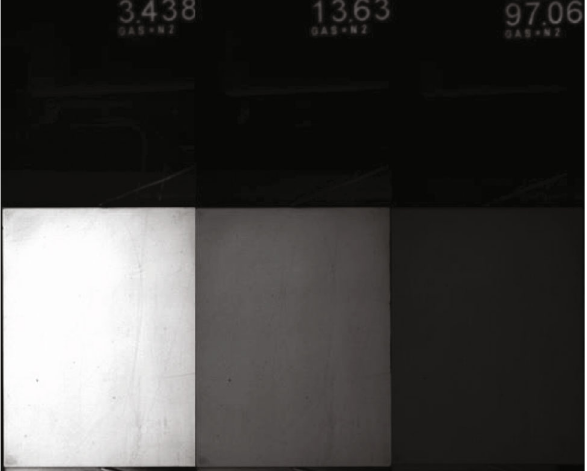
Figure 5: Black and white images of light intensity on the sprayed aluminum coupon in the calibration vacuum